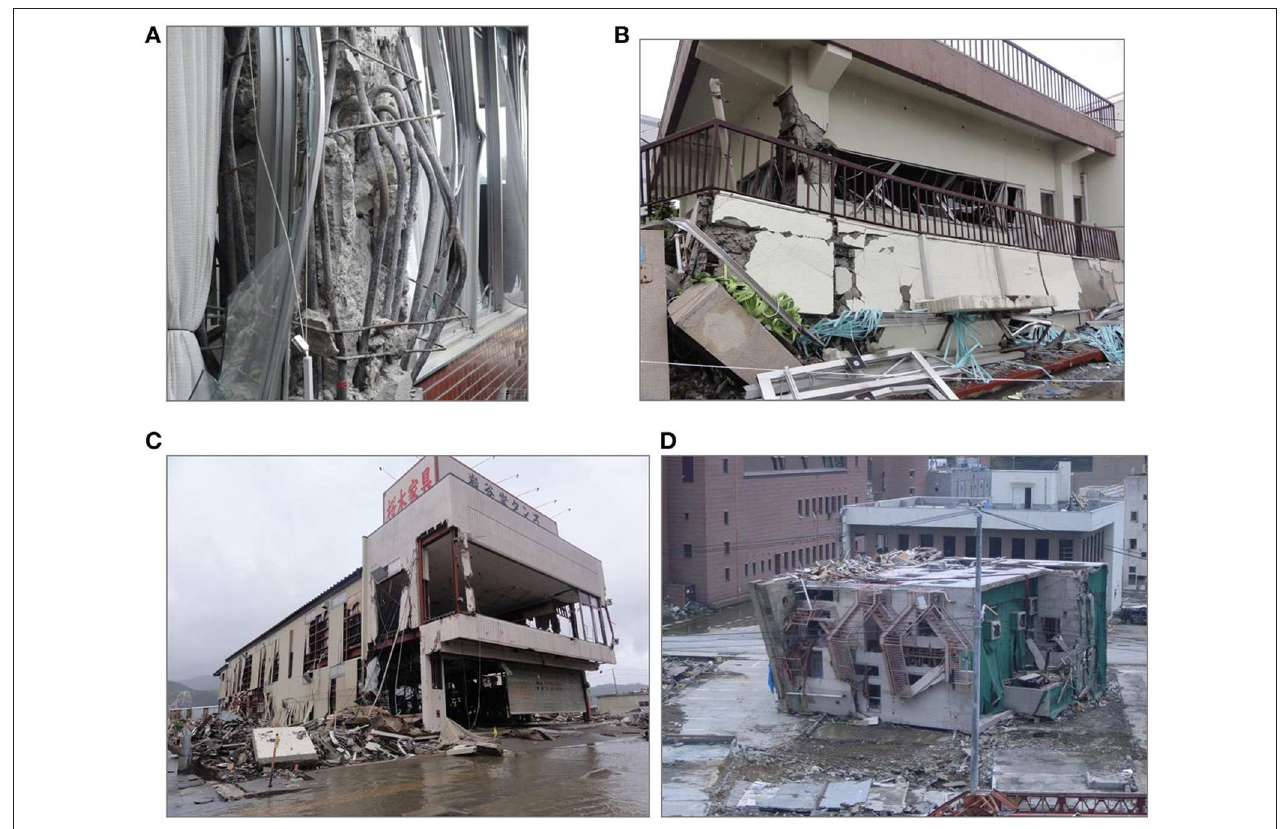
FIGURE 6 | Structural damage following the Tohoku earthquake. (A) Buckling at mild-span of column of Sukagawa city office building. (B) Soft story collapse of RC building at Sendai. (C) Damaged steel frame building at Ofunato. (D) Overturned RC building at